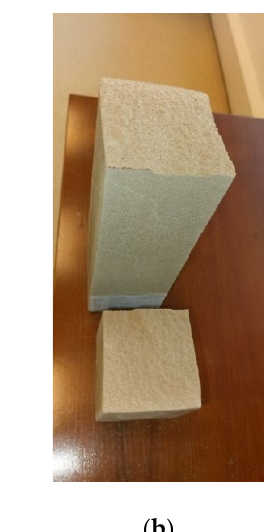
Figure 13. Crack development FC specimen 35030420: ( a ) collapse — first stage, creation of the crack; ( b ) second stage— crack propagation over specimen cross - section; ( c ) third stage —total collapse, crack over full cross -section.